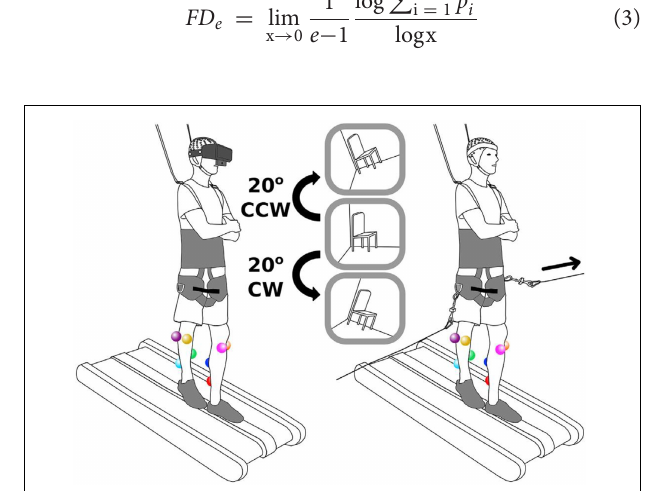
FIGURE 1 | Schematics of the experiment (Peterson and Ferris,